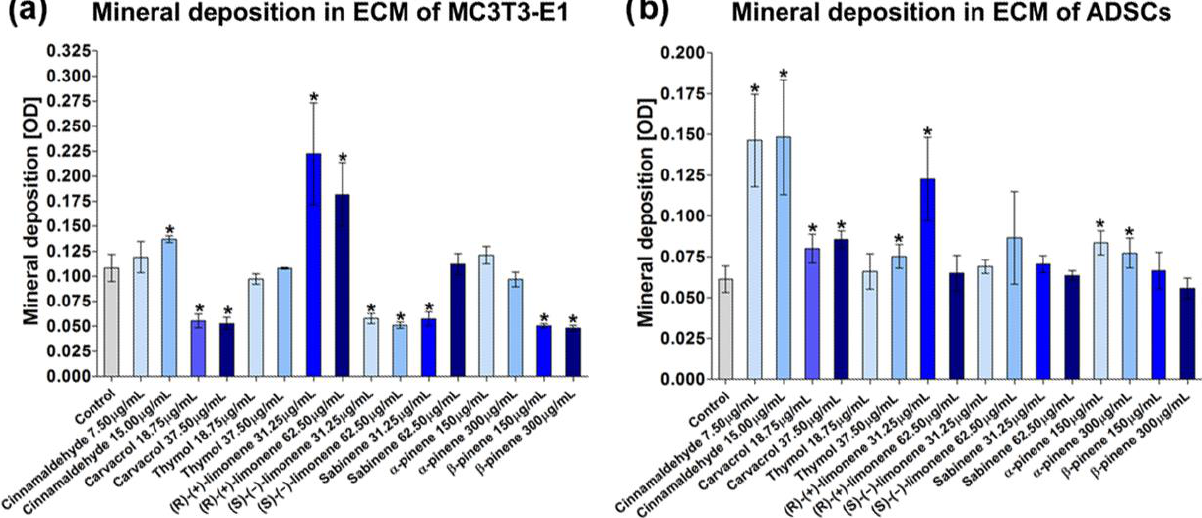
Figure 3. Quantitative evaluation of mineral deposition in ECM of ( a ) mouse primary calvarial preosteoblasts (MC3T3-E1 Subclone 4) and ( b ) canine adipose tissue-derived mesenchymal stem cells (ADSCs) assessed by Alizarin Red S staining. The results were expressed as OD at 450 nm ( * statistically significant results compared to control, n = 3, p < 0.05, unpaired t -test). Osteogenic differentiation results in bone ECM formation and mineral